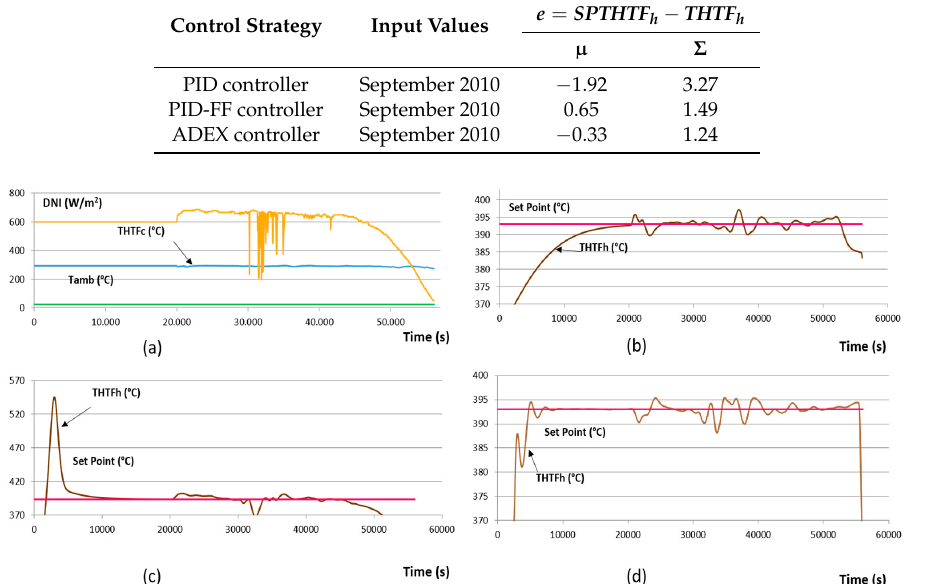
Figure 10. Results obtained for the different algorithms using real data, April 2011. DNI, ambient temperature, and HTF temperature at the solar field input ( a ); HTF temperature for the PID-FF ( b ); PID ( c ); and ADEX ( d ) regulators.